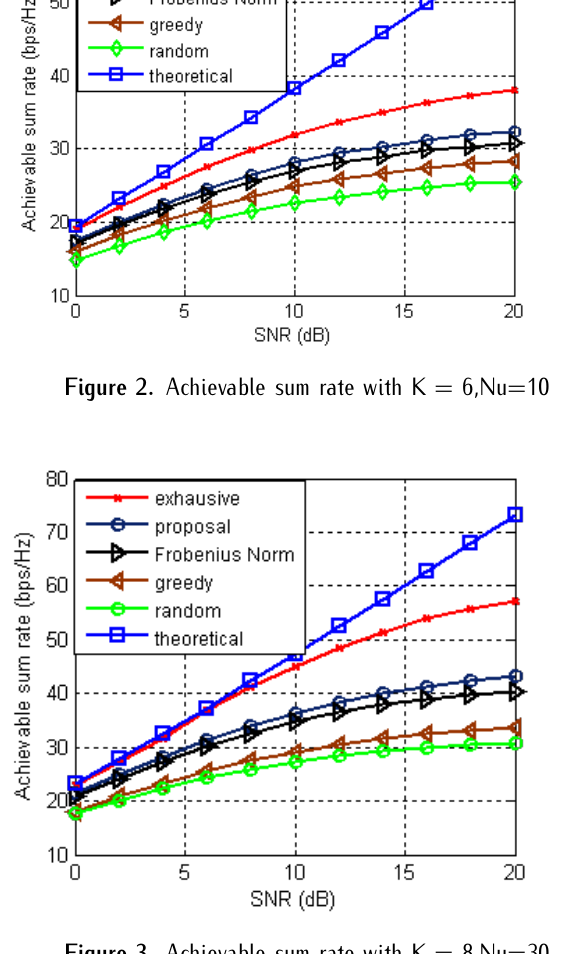
Figure 3. Achievable sum rate with K =